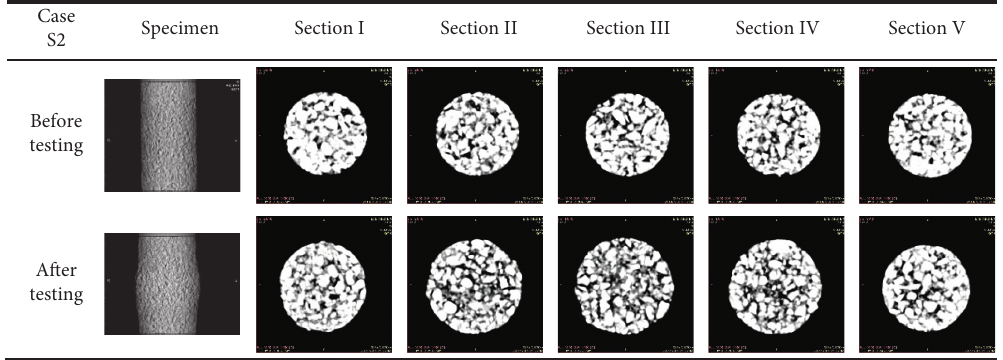
Figure 8: Typical CT images of the frozen coarse-grained specimen of case S2 before and after